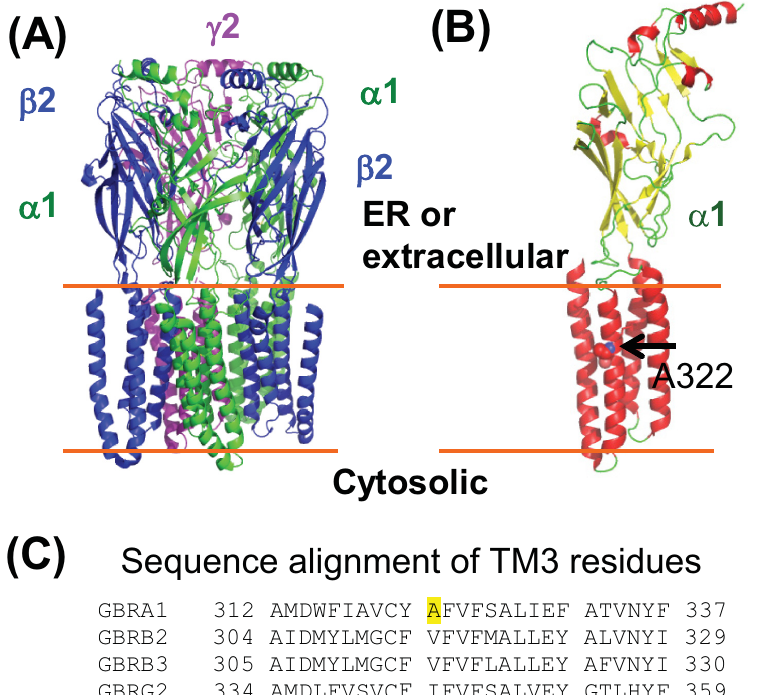
Fig 1. Molecular structures of GABA A receptors. ( A ) A cartoon representation of the major pentameric GABA A receptor subtype in the central nervous system. It contains two α 1 subunits, two β 2 subunits, and one γ 2 subunit. This model was constructed from the cryo-EM structure (6D6U.pdb) [22] by using PYMOL. ( B ) Topology of the α 1 subunit. The large N-terminal domain resides in the ER lumen or extracellular space. Ala322, displayed as a space- filling model and indicated by an arrow, is located in the third transmembrane (TM3) helix. ( C ) Sequence alignment of TM3 residues of the α 1, β 2, β 3, and γ 2 subunits of GABA A receptors. The sequences are from the following